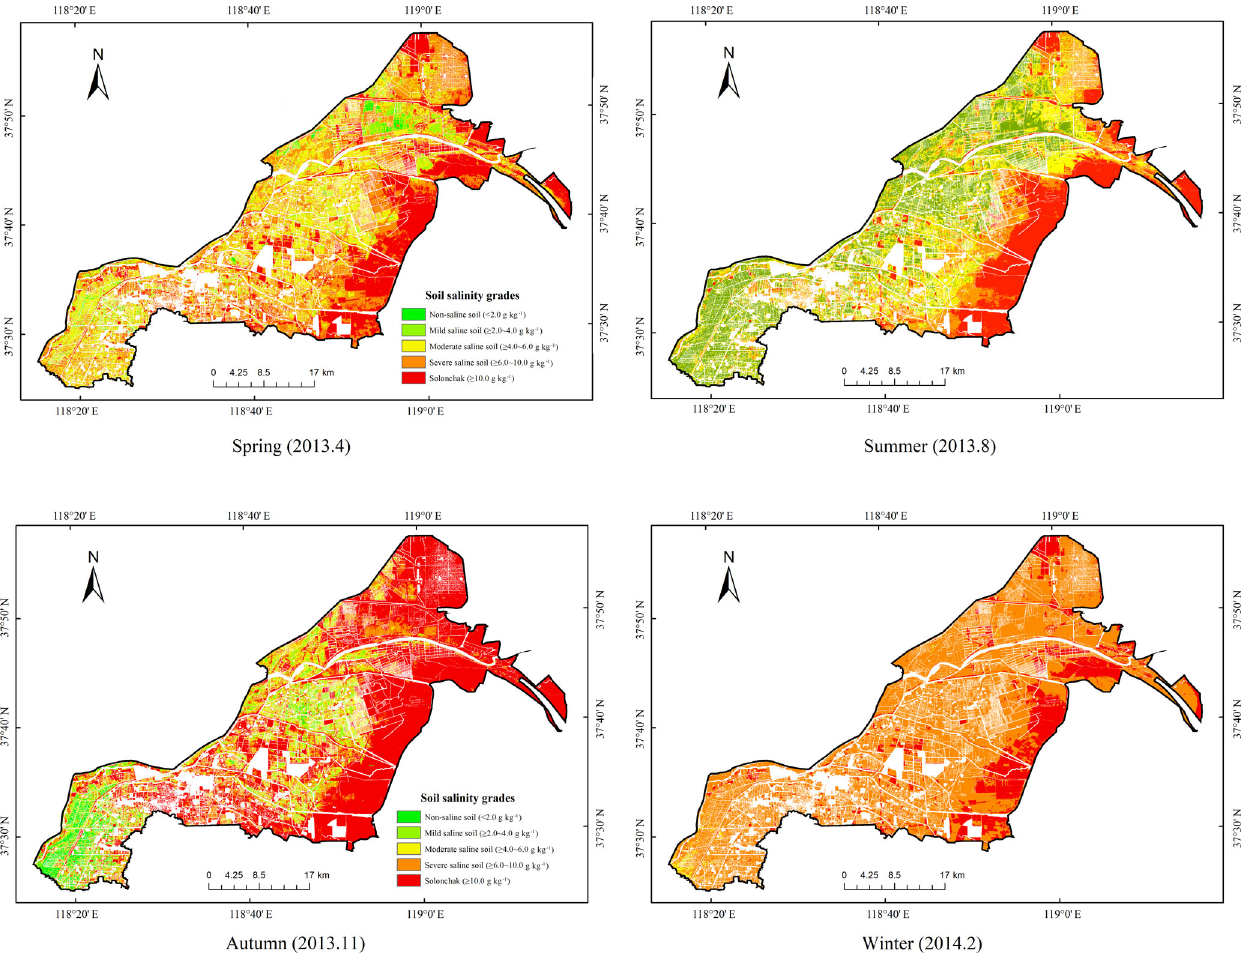
Figure 5. Inversion and distribution of SSC over the four seasons. The data sources were Landsat images respectively taken on 6 May 2013, 18 August 2013, 6 November 2013 and 26 February 2014 from the © United States Geological Survey, https://earthexplorer.usgs.gov/ (last access: July